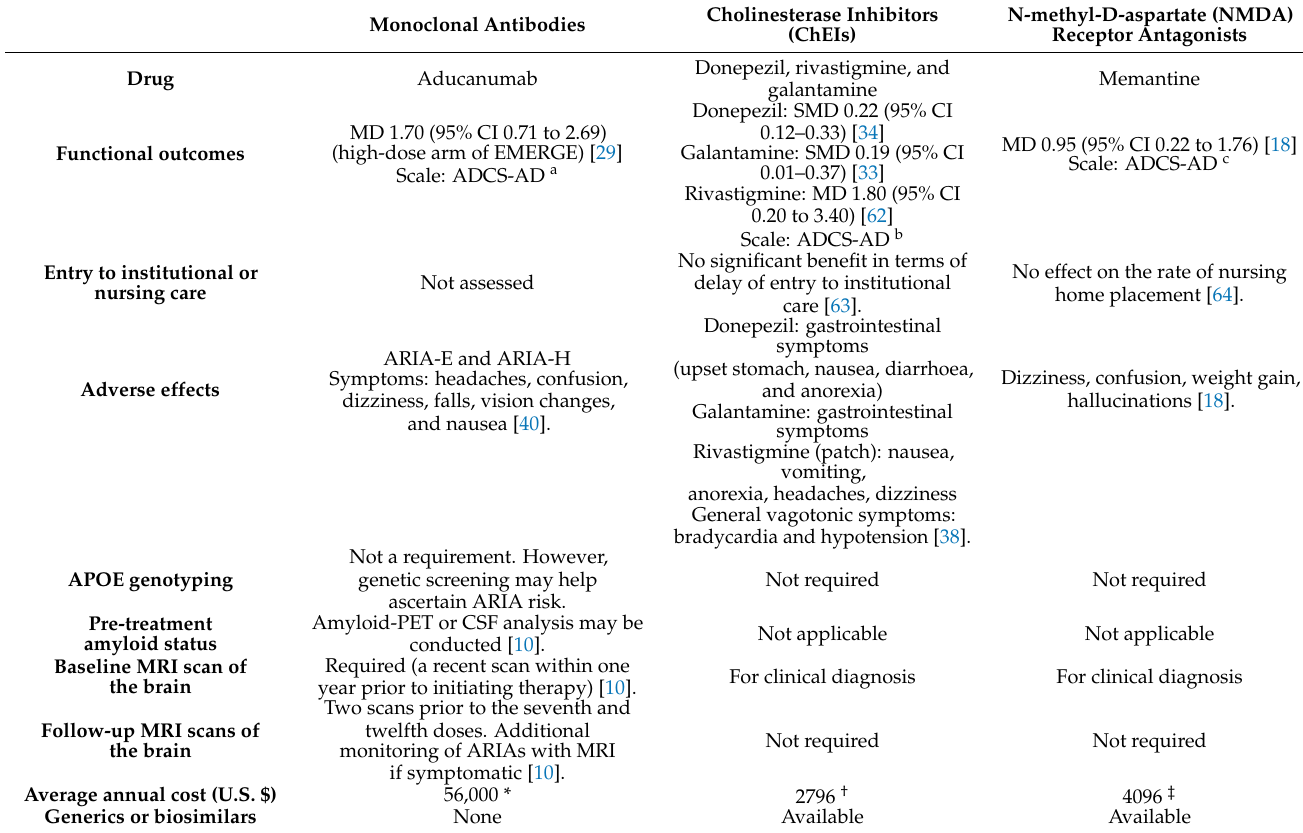
Table 2. Additional differences between aducanumab and conventional drugs for the treatment of